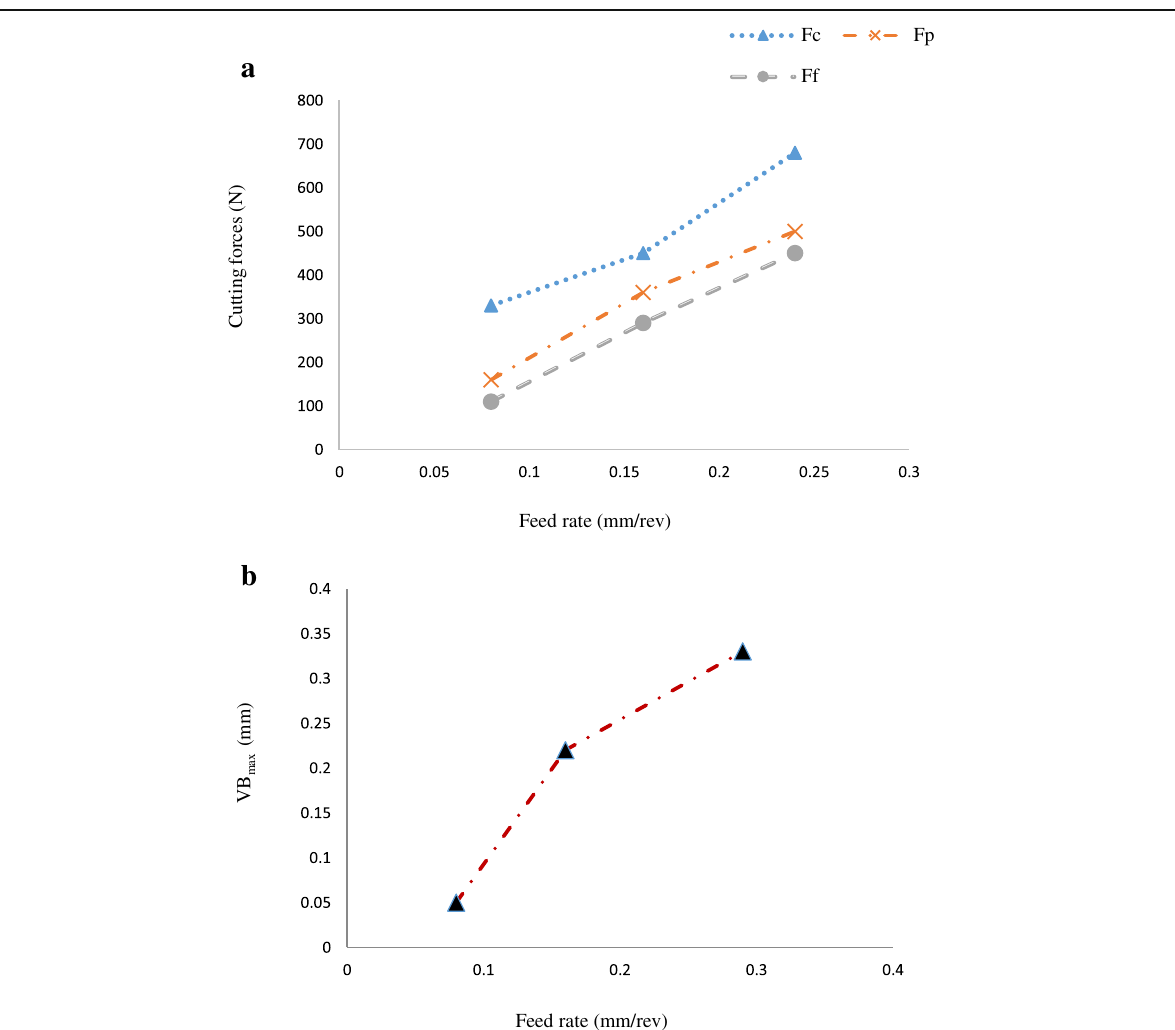
Fig. 6 a The effect of feed rate on the cutting forces and b the effect of feed rate on the maximum flank wear at 0.8 mm nose radius, 0.5 mm cutting depth, and 1000 rpm spindle